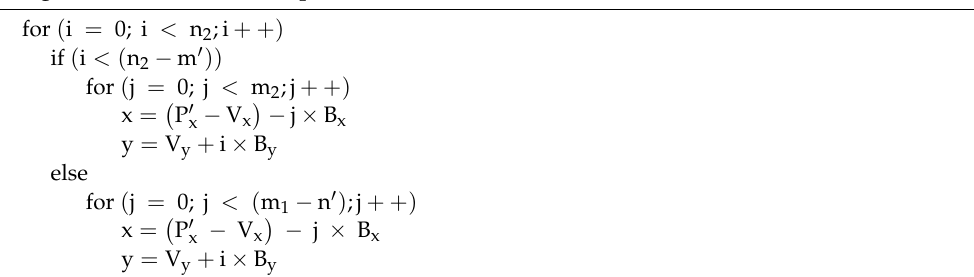
Algorithm 4. Vertical overlap coordinate calculation